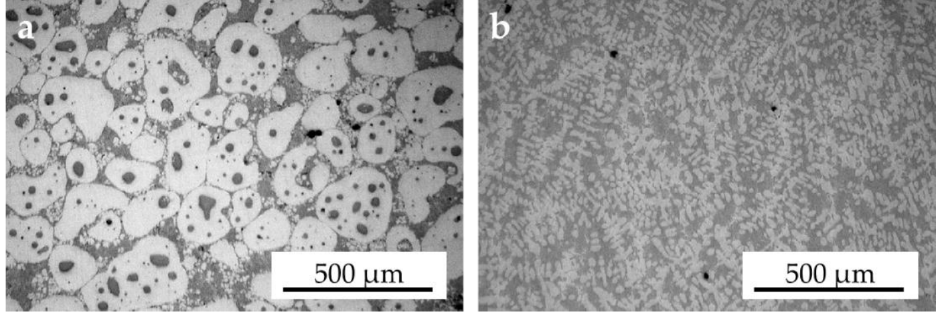
Figure 1. Typical microstructures of an A356 component obtained by ( a ) thixocasting (billet preheated to a solid fraction of 0.52–0.54) and ( b ) conventional casting (pouring temperature = 680 ◦